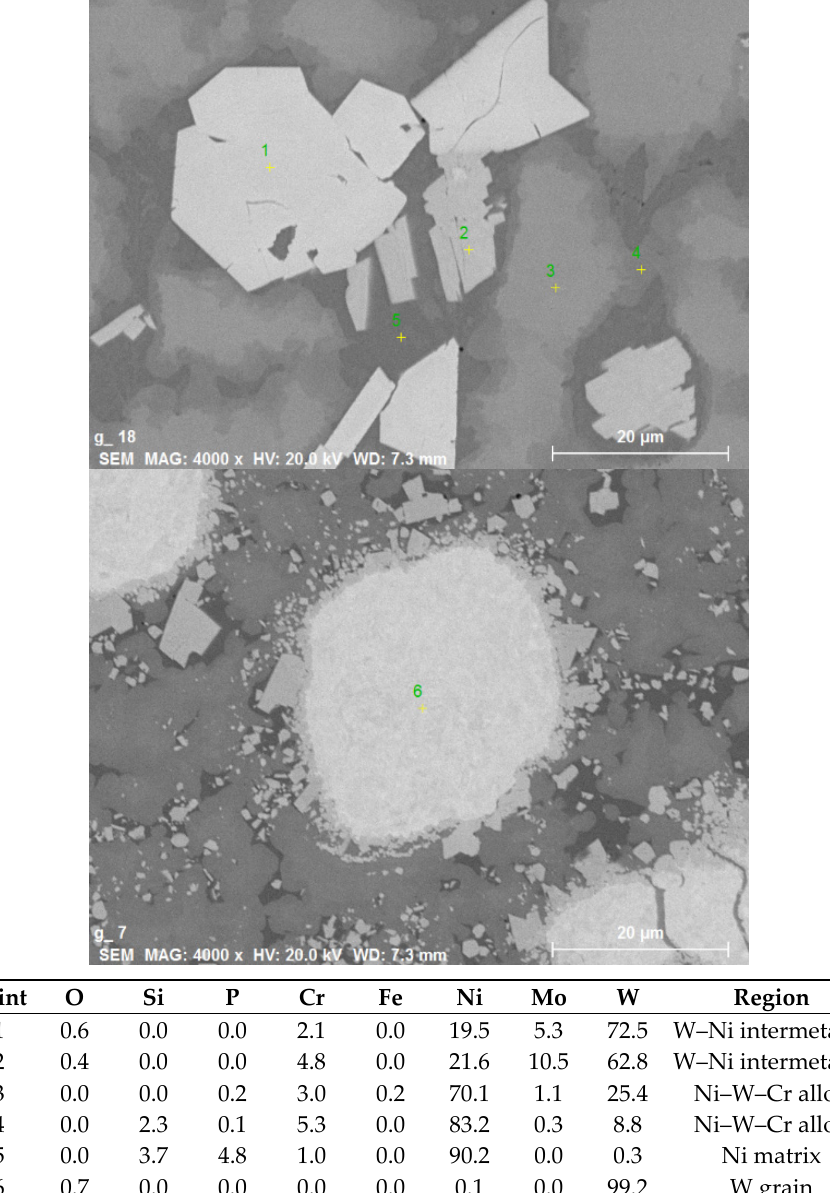
Figure 6. Results of local EDS analysis on the cross section of 50% W sample on a graphite substrate.